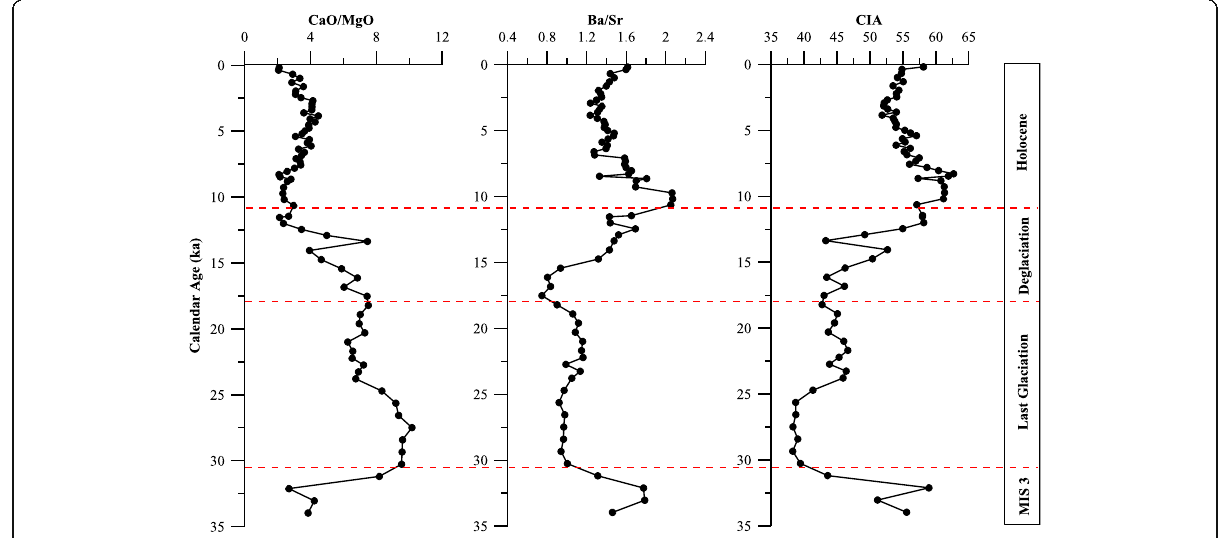
Fig. 6 Distributions of CIA, CaO/MgO, and Ba/Sr from core